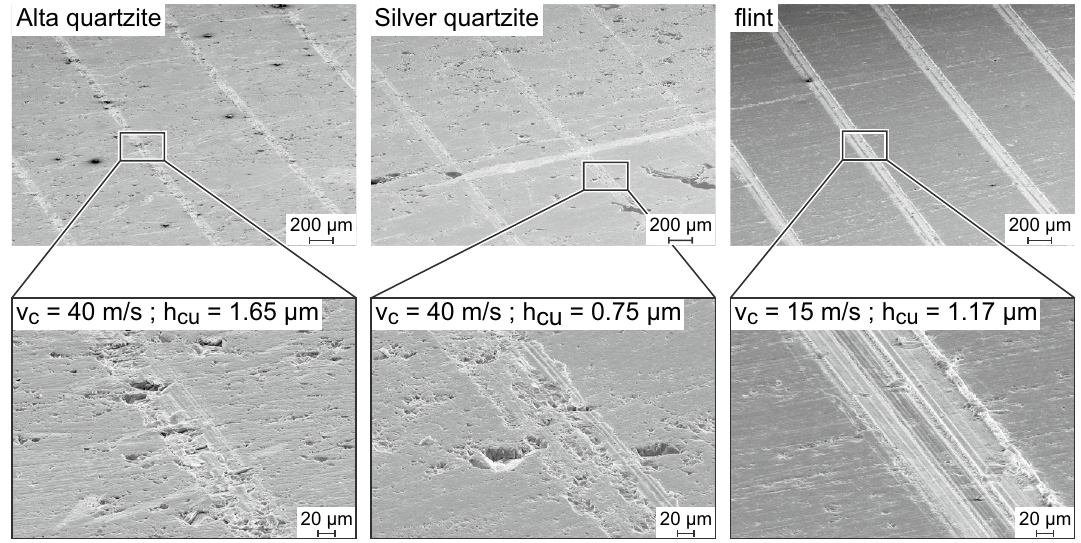
Fig. 9 SEM-images of scratches in flint and the